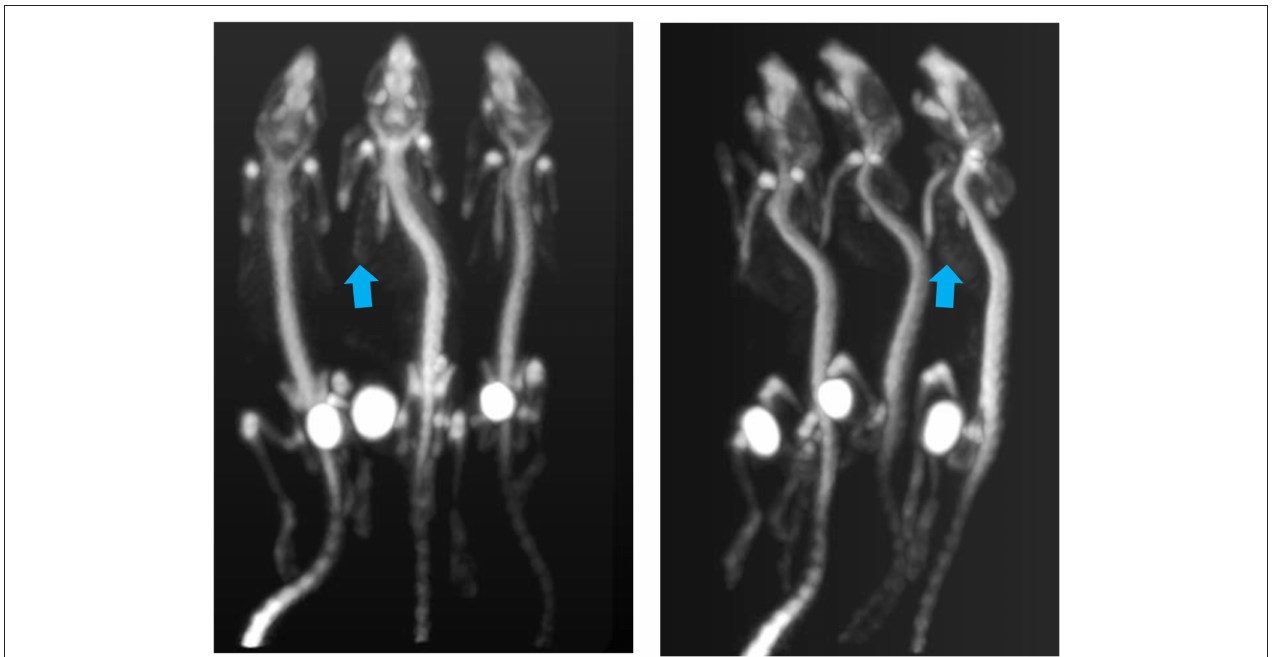
FIGURE 8 | PET MIP images showing bone tracer Na[ 18 F]. Arrows point to visible ribs as an indication of good resolution. Tracer uptake time was 1h and scan time 18min. Each of the animals had been injected with 2 MBq.